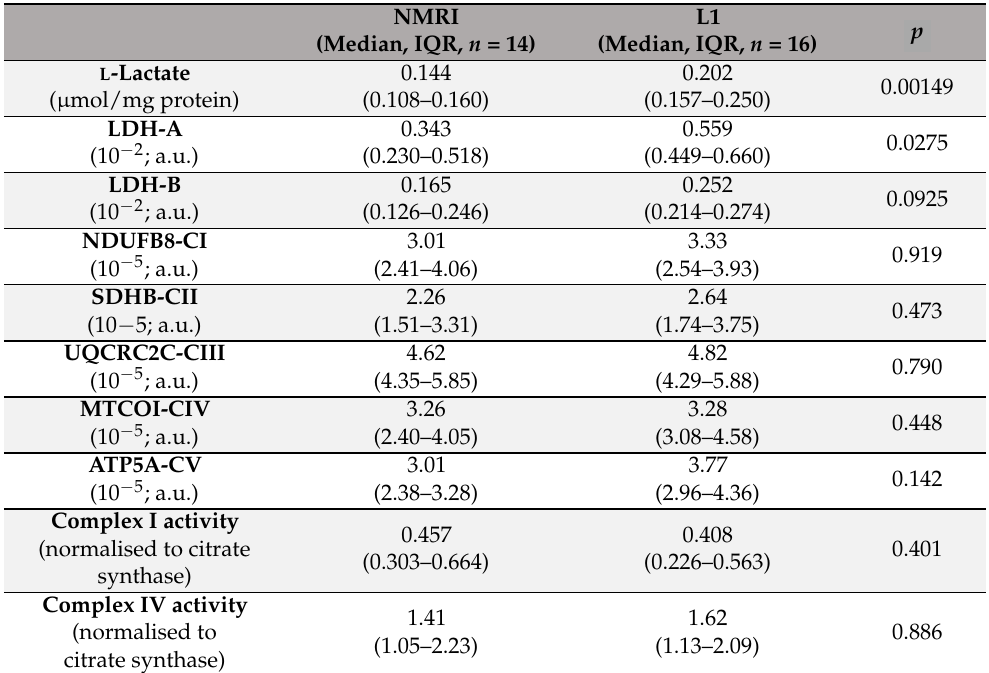
Table 2. Summary of the L -lactate and mitochondrial metabolic characterisation of the L1 transgenic mice in comparison with their respective wild-type control mice, NMRI. Data are expressed as median values ± IQR ( n = 14–16). Differences are considered statistically significant when p < 0.05. LDH-A, lactate dehydrogenase subunit A; LDH-B, lactate dehydrogenase subunit B; NDUFB8- CI, NADH:ubiquinone oxidoreductase subunit B8-complex I; SDHB-CII, succinate dehydrogenase complex iron-sulphur subunit B-complex II; UQCRC2-CIII, ubiquinol-cytochrome c reductase core protein 2-complex III; MTCOI-CIV, mitochondrial cytochrome c oxidase subunit 1-complex IV; ATP5A- CV, ATP synthase F1 subunit alpha-complex